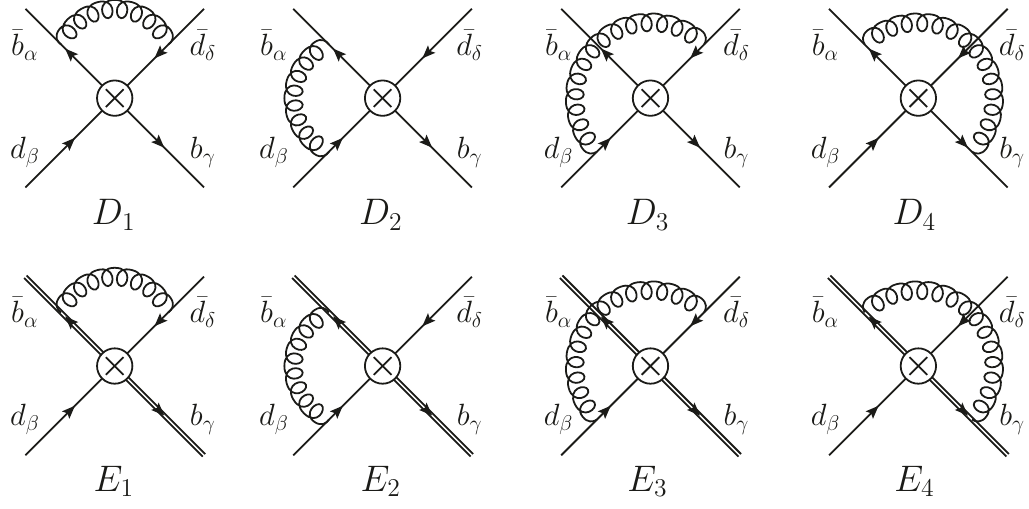
Figure 1 . QCD ( D i ) and HQET ( E i ) diagrams that enter the matching. Symmetric diagrams are not